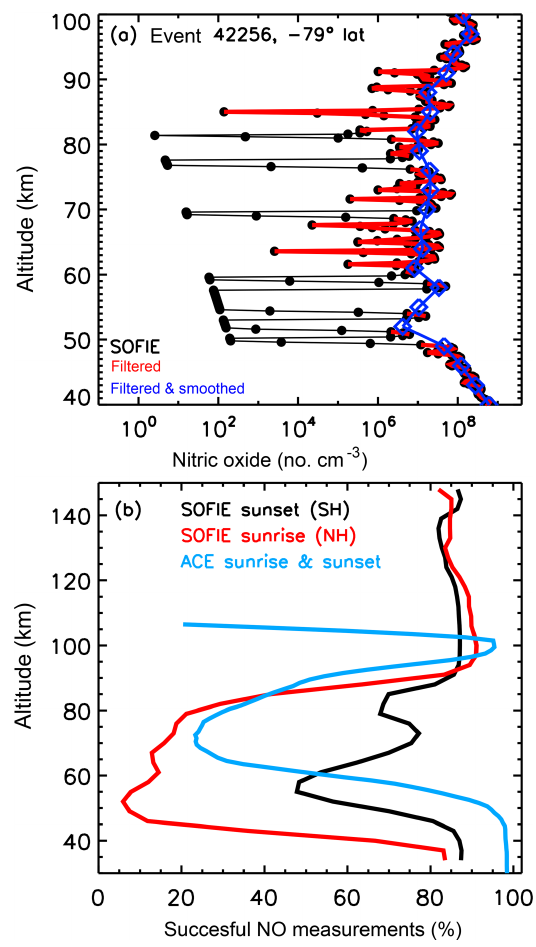
Figure 1. (a) Example SOFIE NO retrieval from 12 March 2011, showing the original profile, the profile with erroneous values fil- tered (see text), and the filtered profile smoothed to 3km spac- ing. (b) The percentage of successful NO retrievals vs. altitude for SOFIE sunrise and sunset observations. ACE results are similar for sunrise and sunset, and are shown here for all measurements com- bined. Note that MIPAS only reports successful